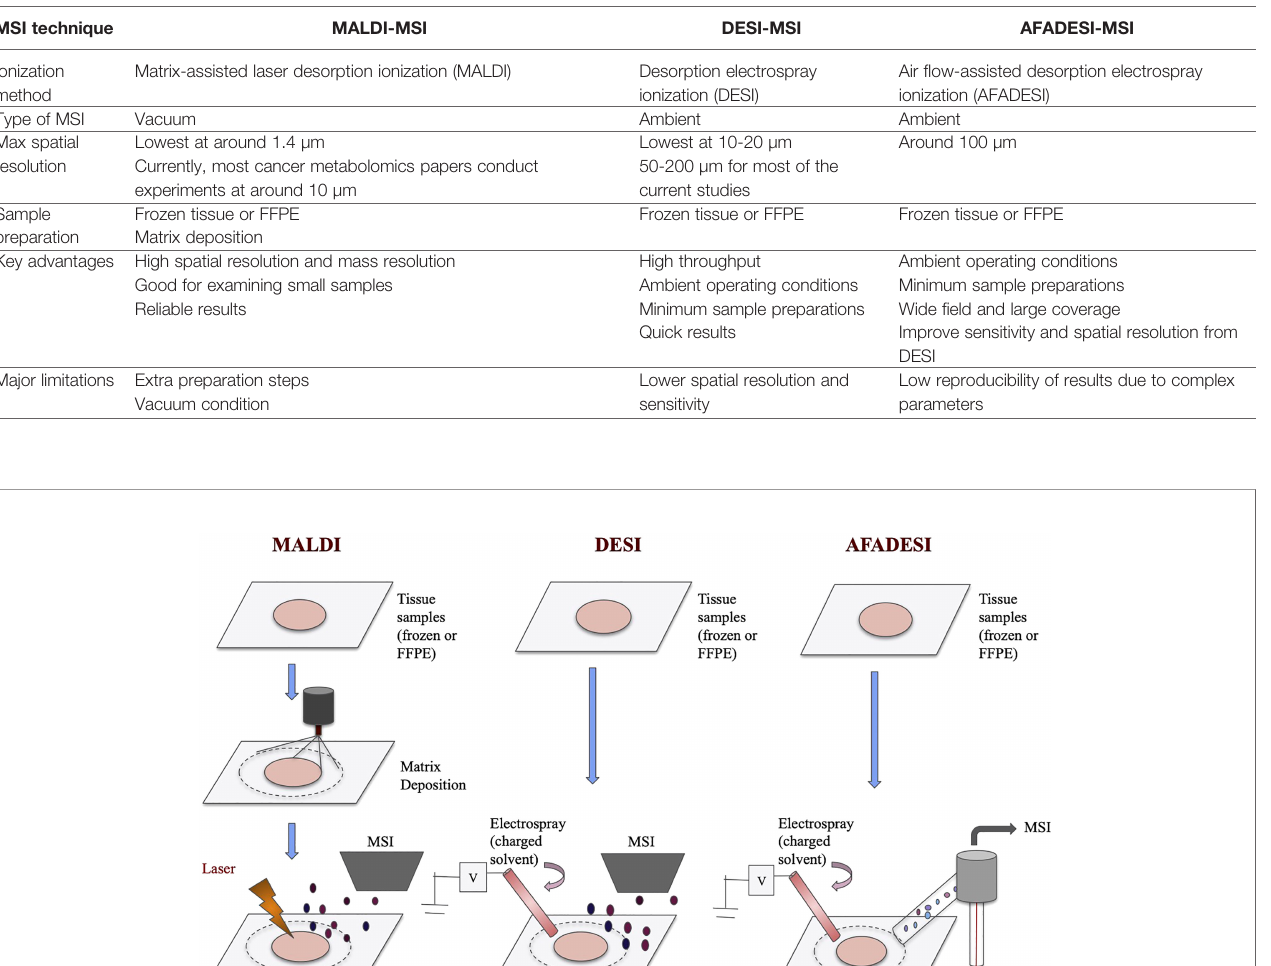
TABLE 1 | Contraction between MALDI-MSI and